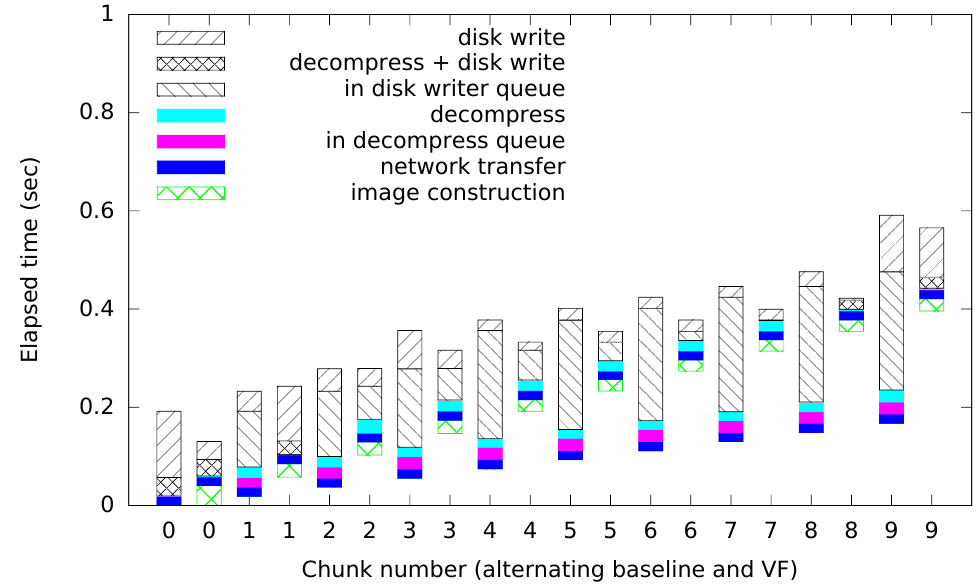
Figure 9: Timeline of chunk deployment for baseline Frisbee and VF. The x-axis interleaves per-chunk measurements from runs of baseline Frisbee and VF for the first 10 chunks of the same image. The y-axis shows elapsed time (relative to the first read of the first chunk) for each of the chunks broken down by